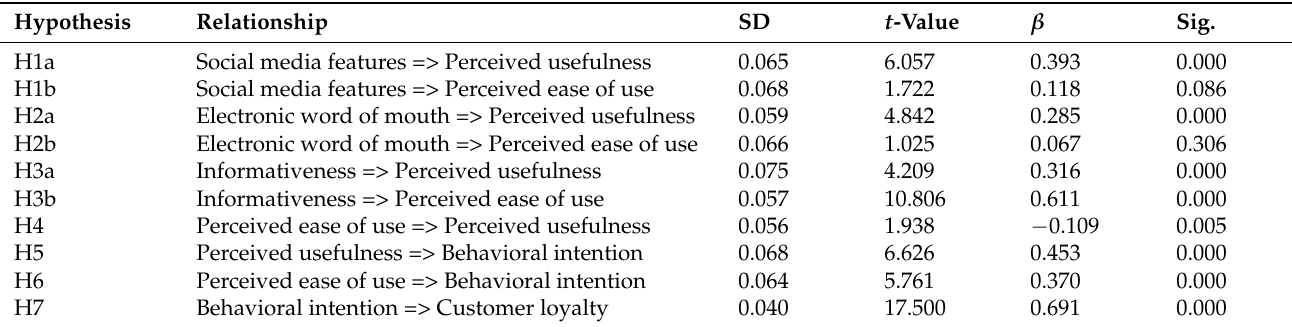
Table 5. Hypothesis